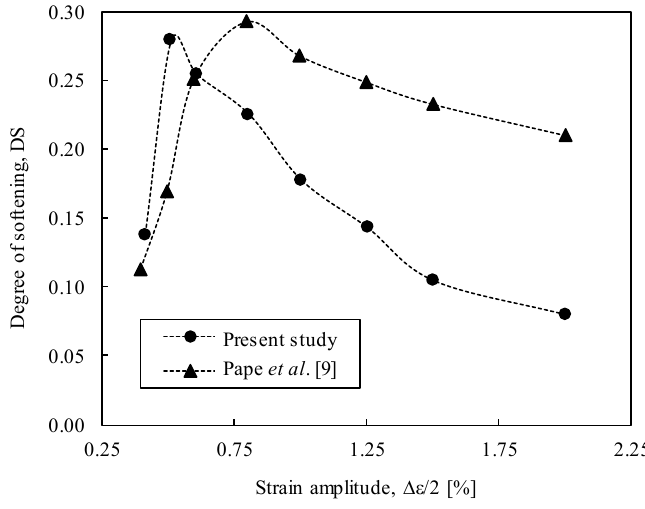
Figure 7. Degree of softening versus strain amplitude.